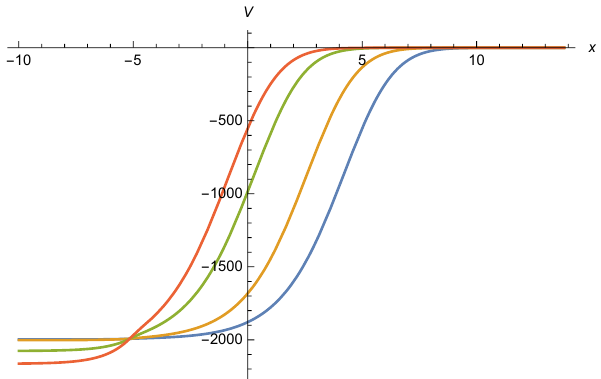
Figure 23. Potential in the Einstein frame V E as function of x = ln ˜ ρ , for ξ ∞ = 2 · 10 − 5 (blue), 10 − 4 (orange), 10 − 3 (green), and 0.003 (red), from right to